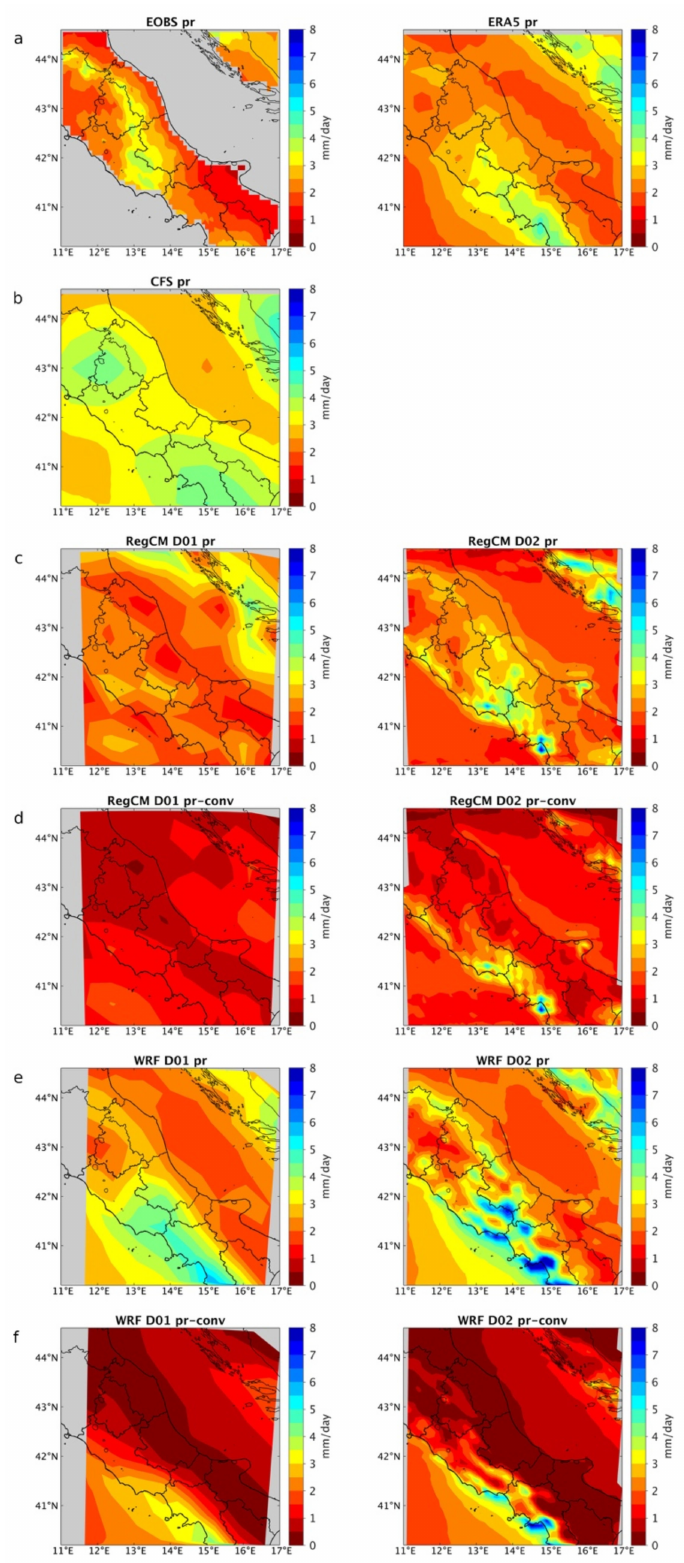
Figure 4. Comparison of the climatologically averaged daily precipitation over the reference period for ( a – c , e ) total daily mean precipitation for reference products EOBS and ECMWF ERA5, CFS, RegCM (D01 and D02), WRF (D01 and D02), respectively. ( d , f ) convective component of the total precipitation for the RegCM (D01 and D02) and WRF (D01 and D02)